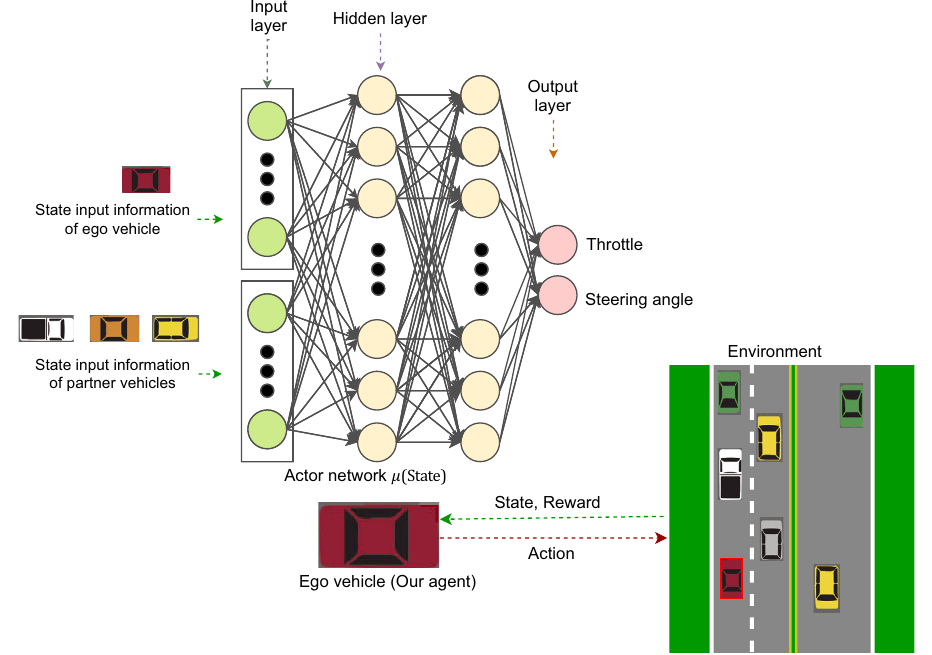
Figure 9. Proposed network settings of the training